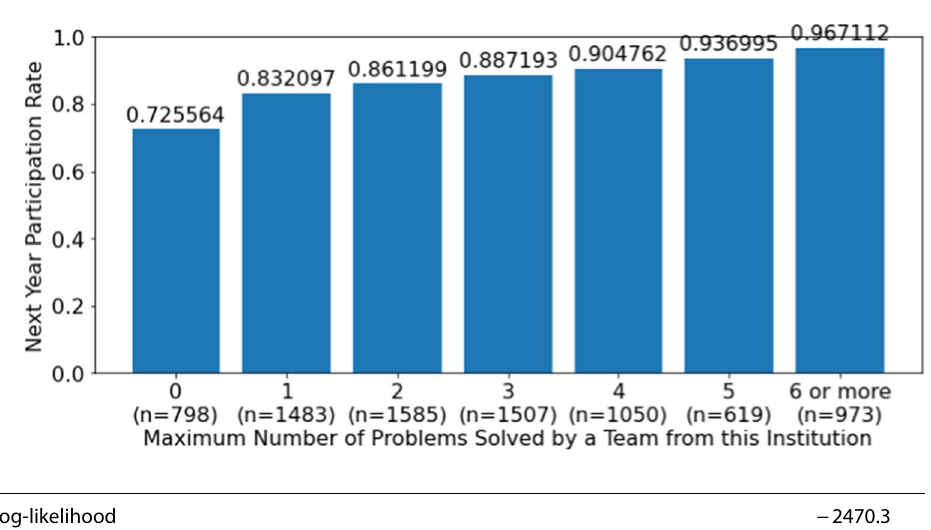
Table 4 Logistic regression model fit